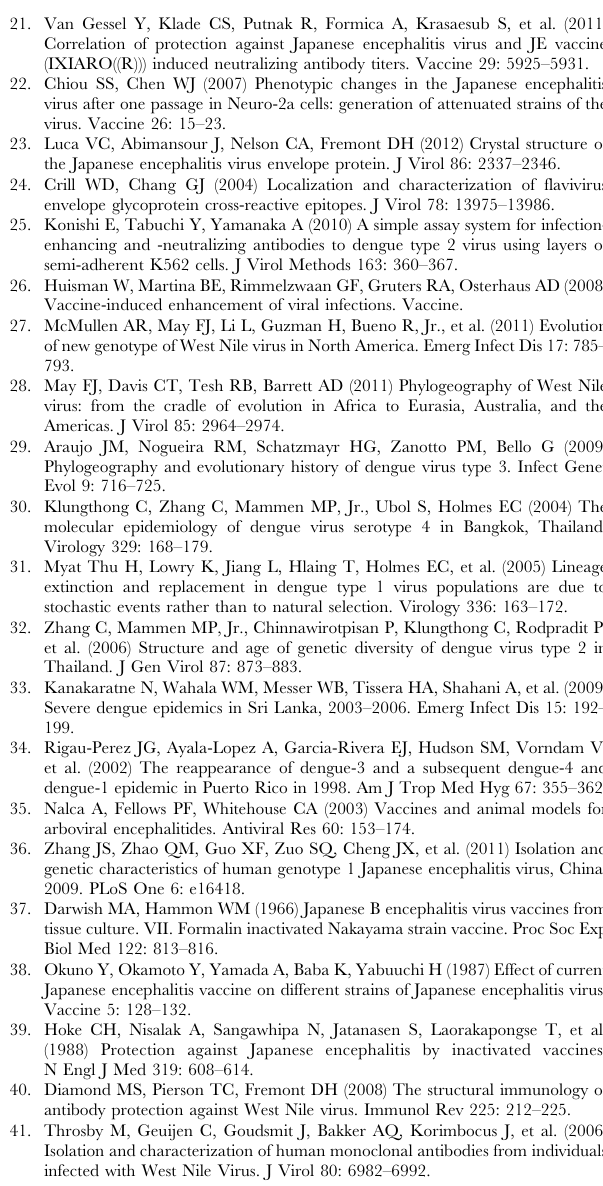
Table S1 Amino acid variations among JEV E protein between genotype and